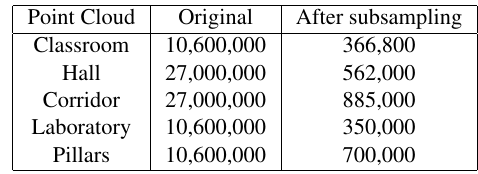
Table 1. Dataset number of points